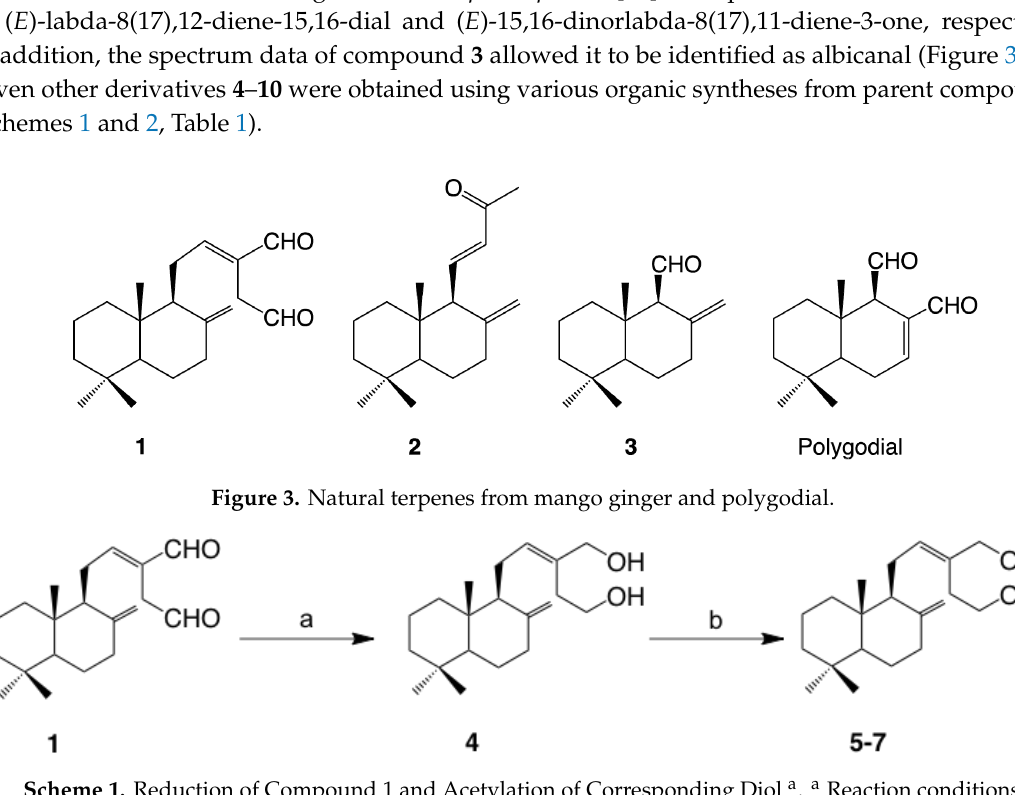
Figure 2. Lipase inhibitory activity of Zingiberaceae extracts against lipase from porcine pancreas. Values are means ± SD ( n = 3).